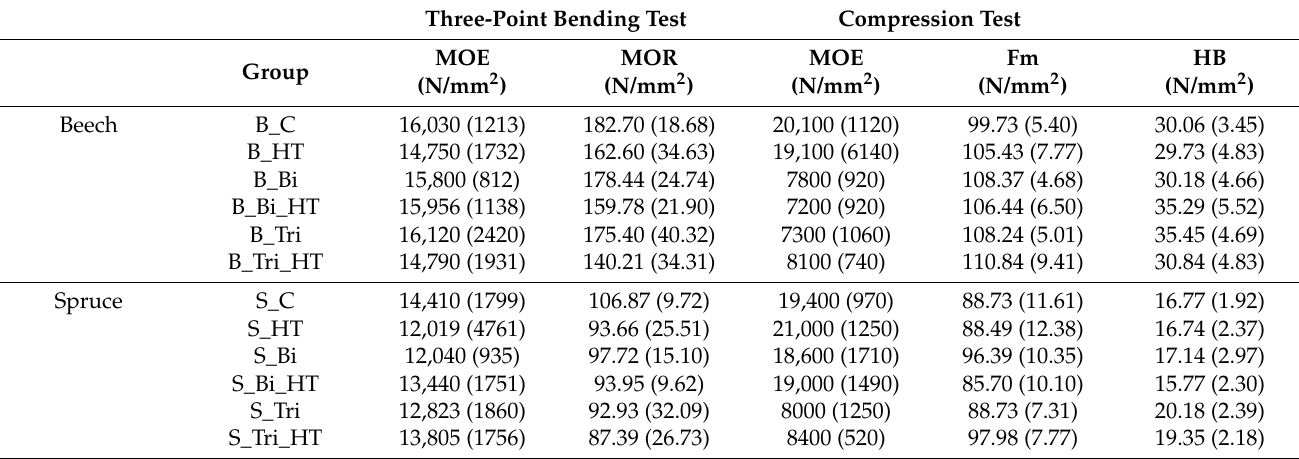
Table 6. Overview of mechanical properties of bicine (Bi)- and tricine (Tri)-treated wood. B = beech, S = spruce, HT = thermal modification, C = control. Standard deviation in brackets ().